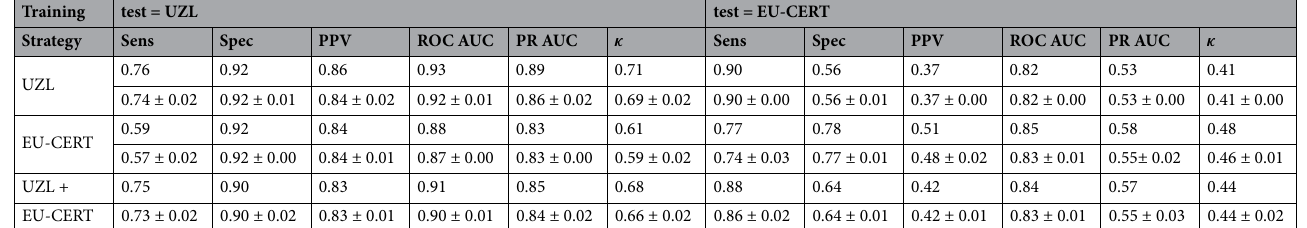
Table 6. Results of the 3 training strategies to evaluate the effect of multiple fQRS annotation criteria. From top to bottom, each row shows the results for the approach trained on UZL, on EU-CERT, and in both. The left side of the table shows the results for test1 UZL data, and the one on the right for